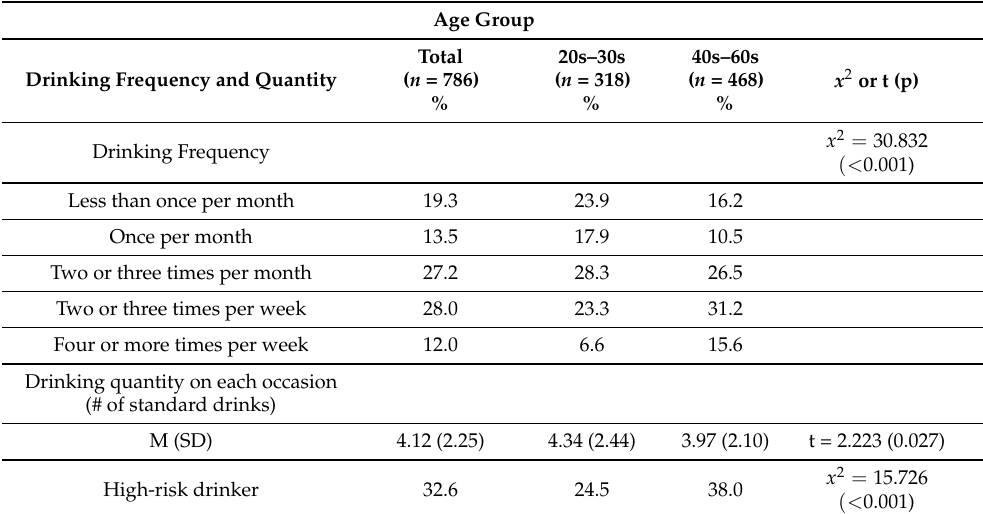
Table 1. Drinking behaviors across age